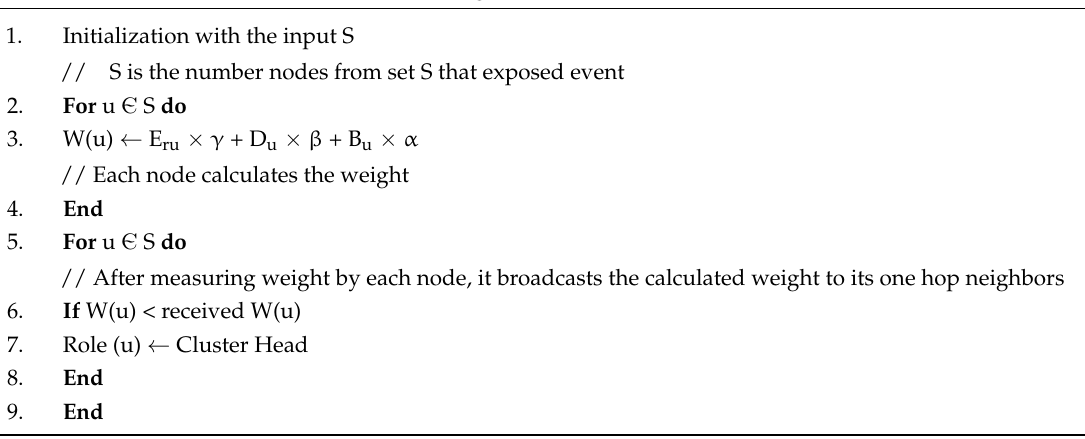
Algorithm 2. Selection of a Cluster Head among